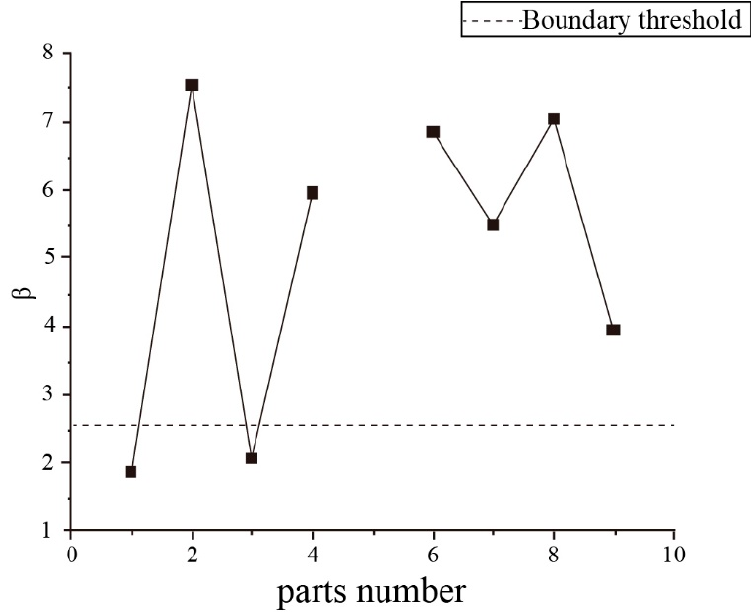
Figure 6. Reliability index at the second stage of the failure process.